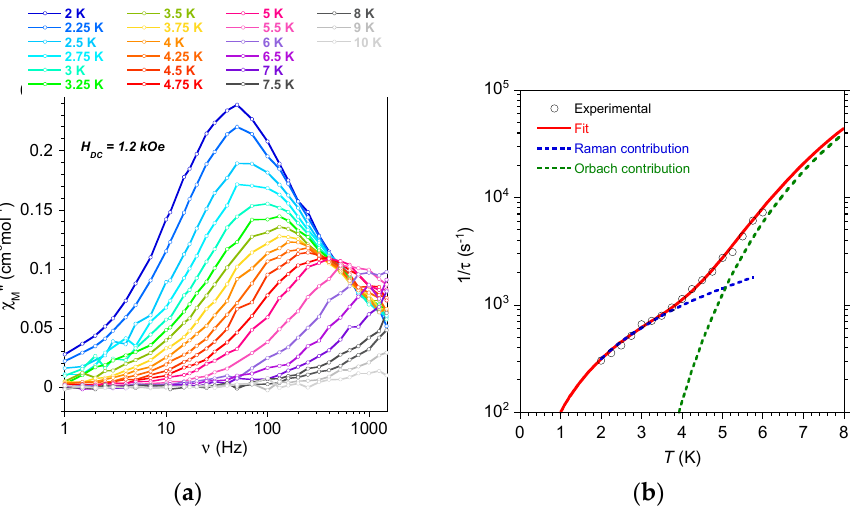
Figure 4. ( a ) The frequency dependence of the out-of-phase component of the AC susceptibility of 2 with an applied field of 1.2 kOe, and ( b ) temperature dependence of its relaxation time with the best fit ( — ) for a combination of Raman and Orbach contributions, and (---) their calculated individual contributions.